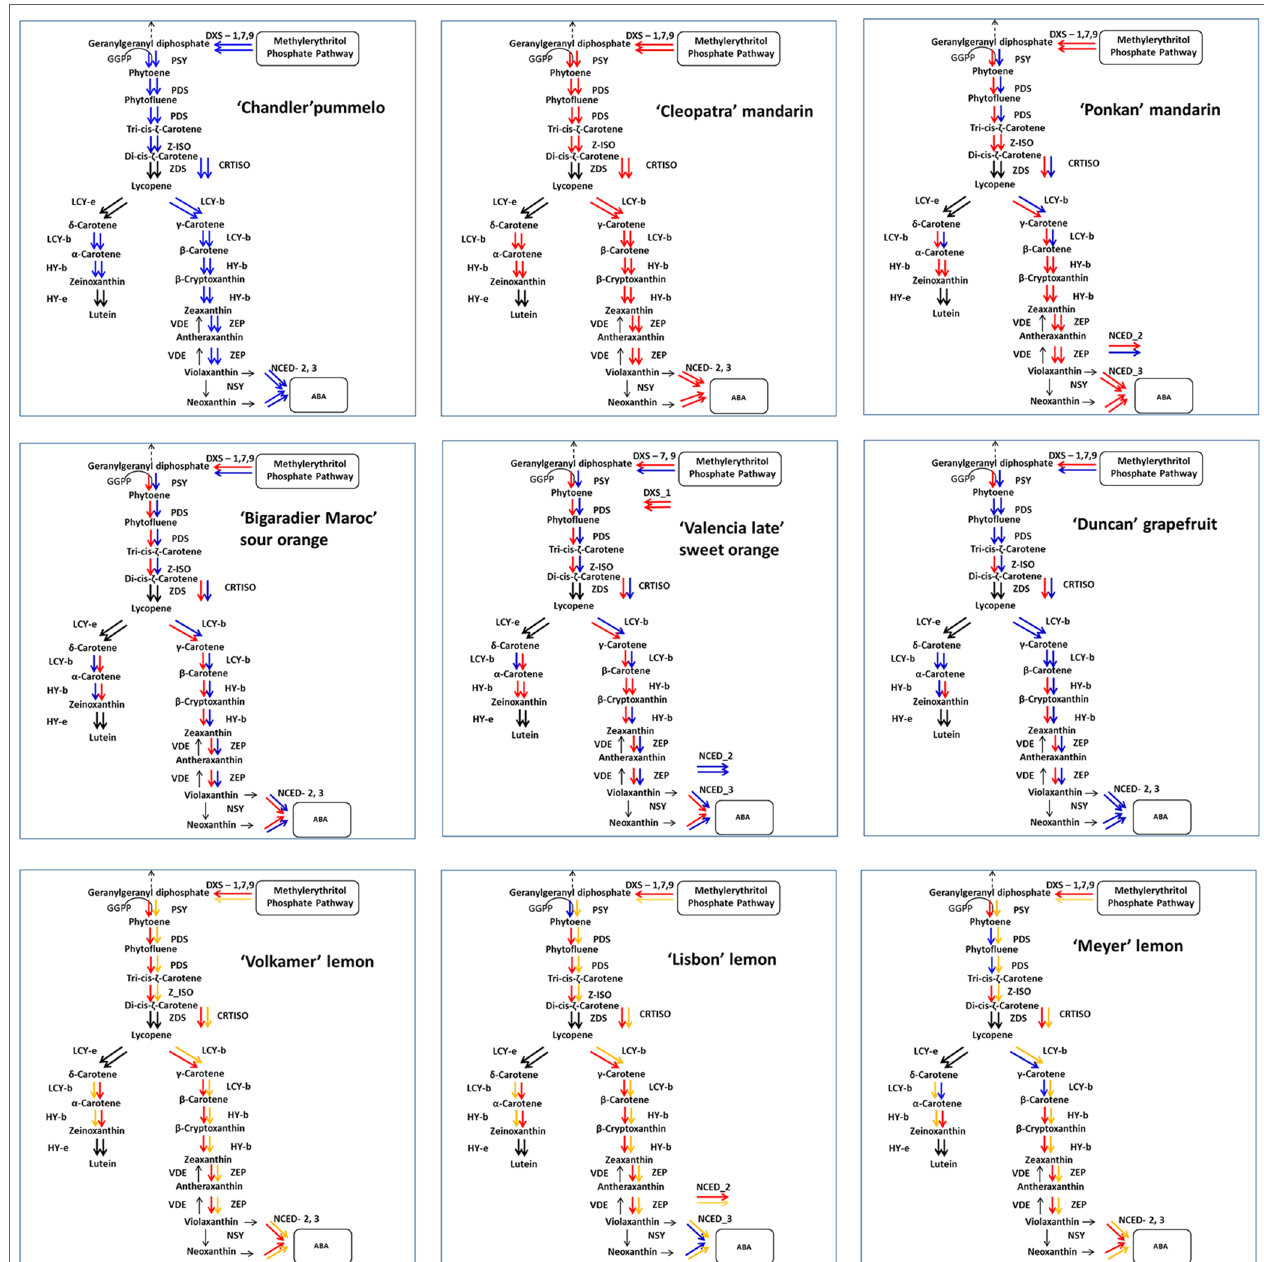
FIGURE 6 | Allelic origins of the carotenoid pathway genes. The red and blue arrows indicate C. reticulata and C. maxima alleles , respectively. The yellow arrows indicate the C. medica allele . The black arrows correspond to alleles with undefined